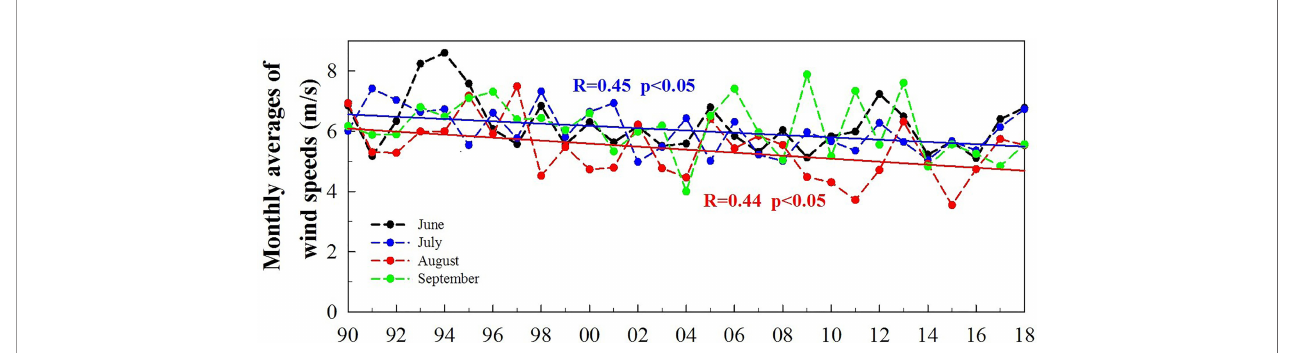
FIGURE 8 | The monthly averages of wind speeds for June, July, August and September, respectively, over 29 years (the red and blue solid lines denote the signi fi cant